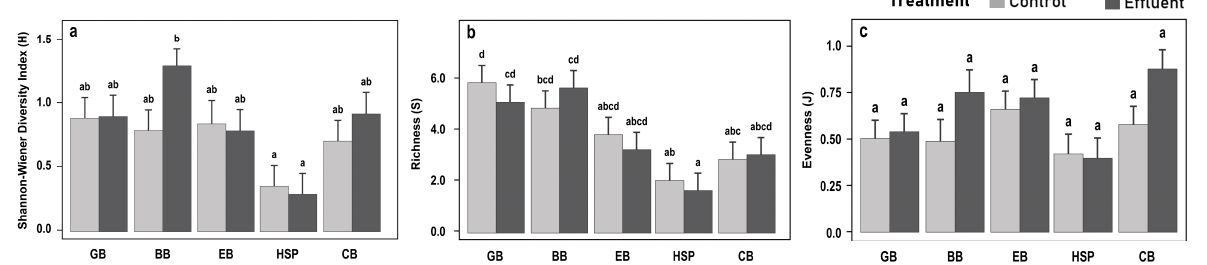
Figure 10. Plot mean and standard error ( n = 5) for overstory ( a ) Shannon–Wiener diversity index; ( b ) richness; and ( c ) evenness. Same letters over bars indicate no differences between treatment levels at α = 0.10. Facility abbreviations are as described in Figure 2. Facilities are arranged in establishment order with GB being first (1978) and CB last